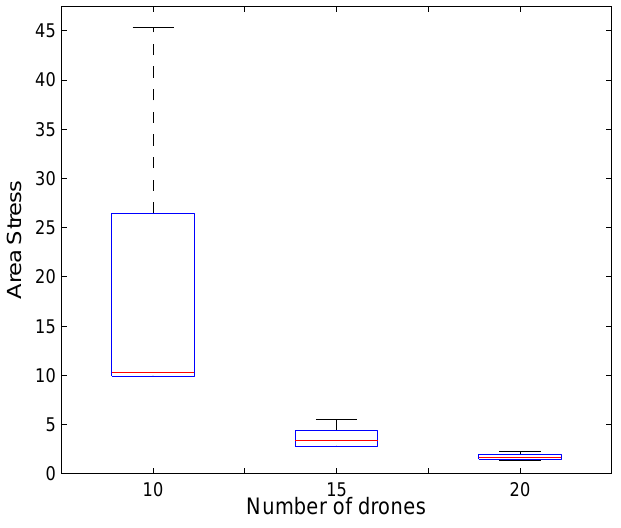
Figure 9. Area stress vs. number of